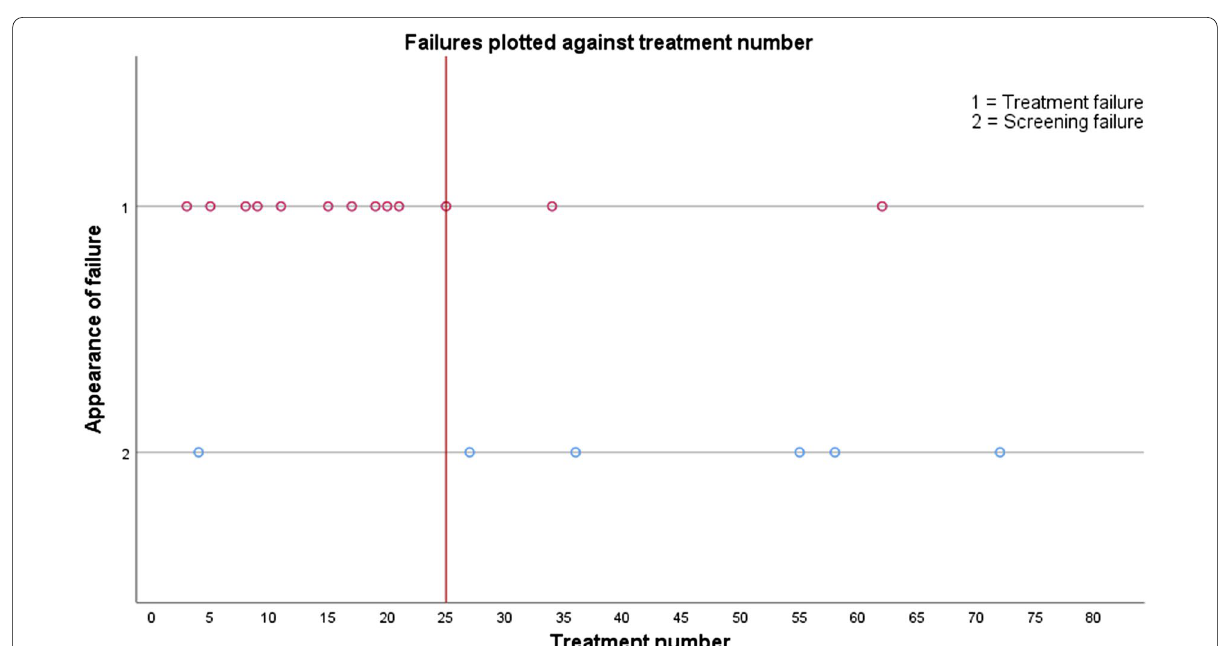
Fig. 2 Appearance of treatment failure when plotted against the number of treatments. Blue dots represent treatment failures; pink dots represent screening